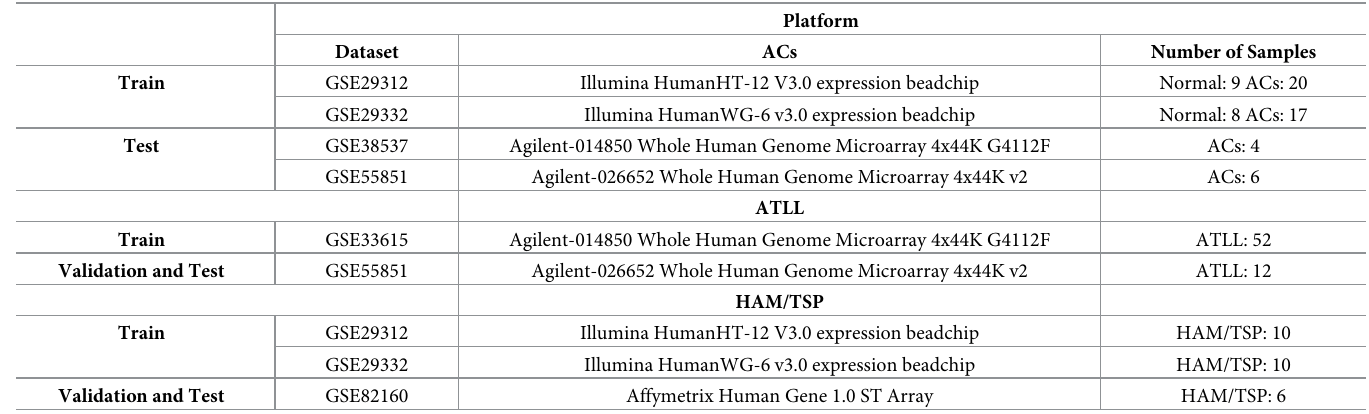
Table 1. Details of datasets included in the analysis and